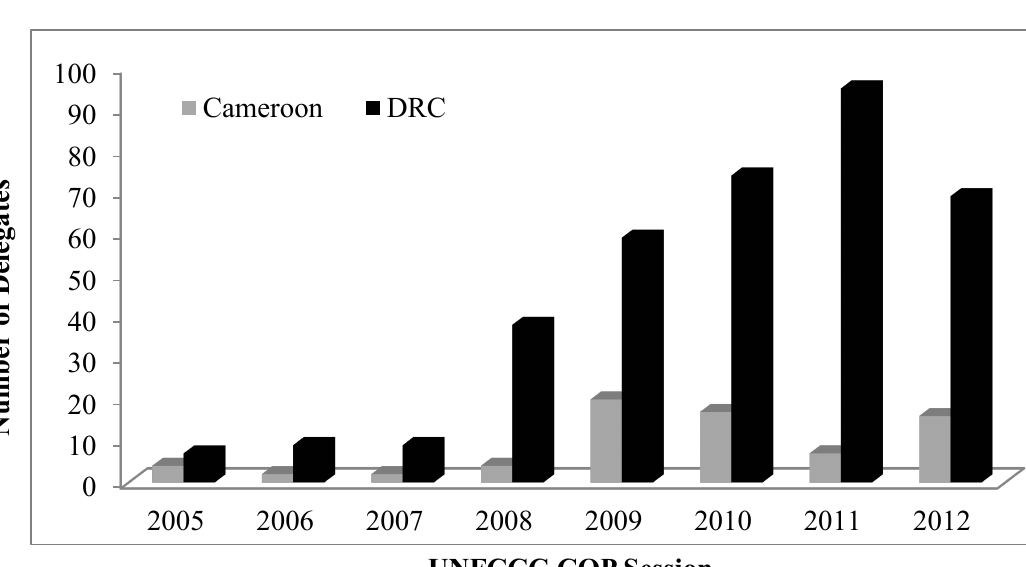
Figure 3. Participation of delegates during UNFCCC COP and REDD+